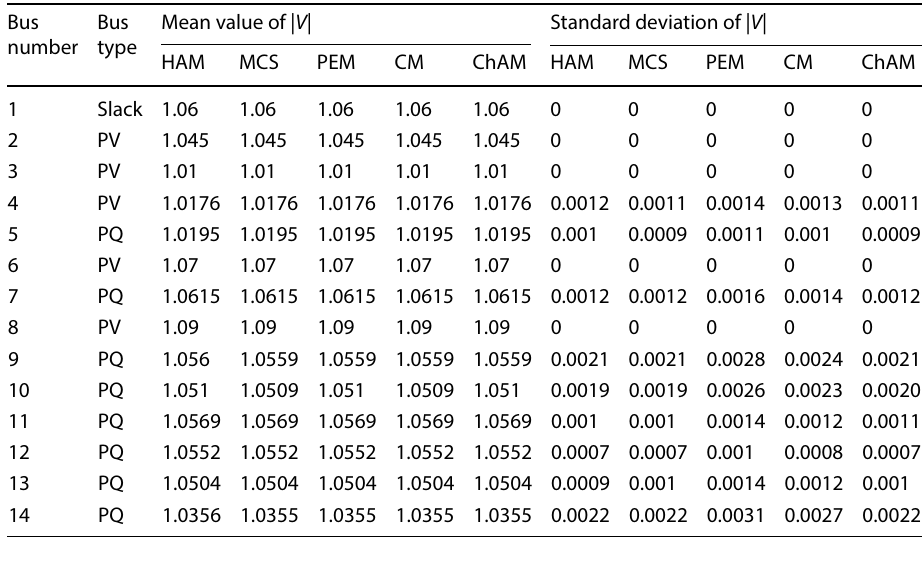
Table 1 Mean and standard deviation of bus voltages in IEEE 14-bus test system